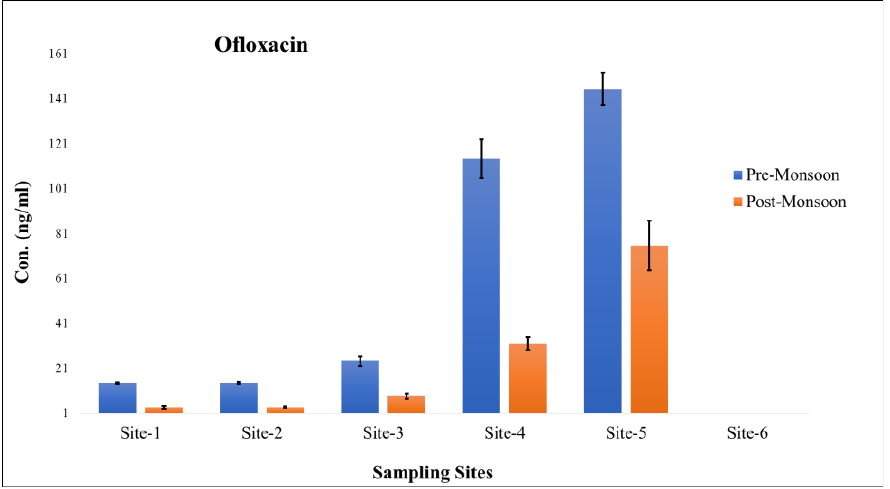
Figure 2. Ofloxacin concentration in surface water samples from various areas along the Yamuna River in Delhi, India.